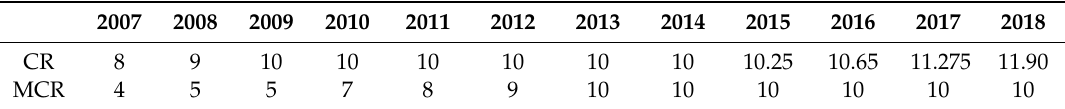
Table 5. The regulatory requirements of CARs and